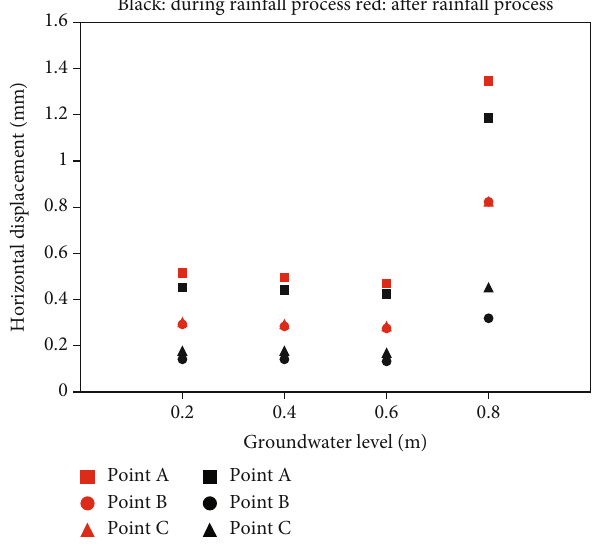
Figure 13: The horizontal displacement at slope reference points A, B, and C with retaining